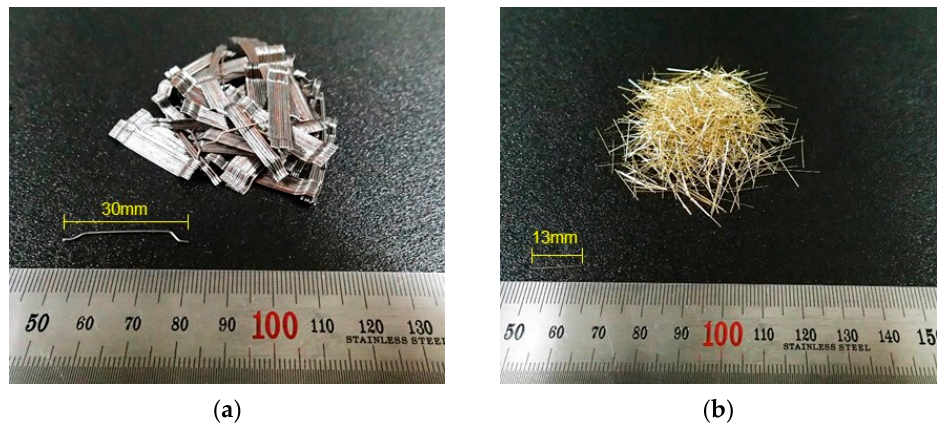
Figure 1. Geometry of the fiber: ( a ) hooked steel fiber (HSF); ( b ) smooth steel fiber (SSF).